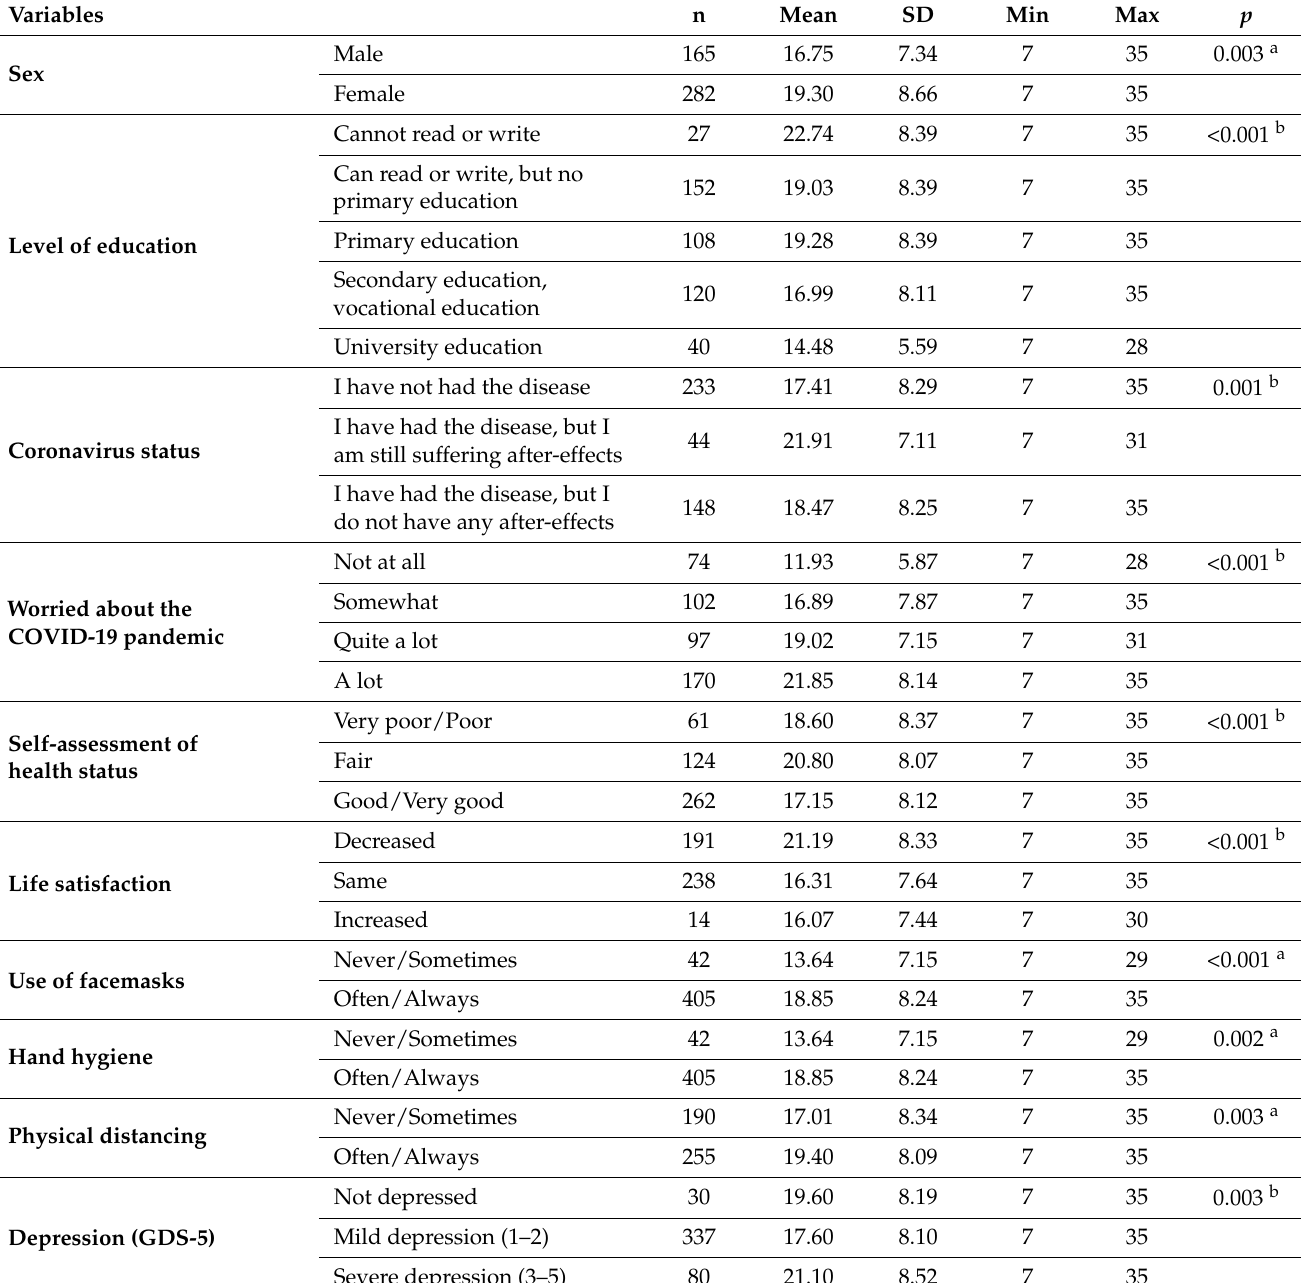
Table 4. Known-groups validity (only significant